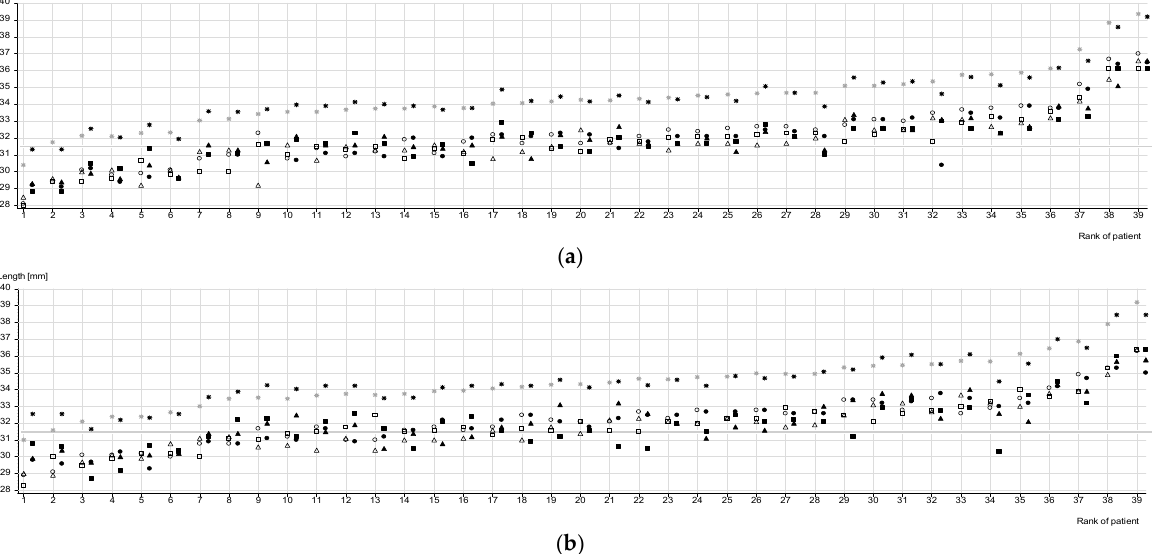
Figure 2. Measurements of the cochlear duct length (CDL) and length at 720° of each cochlea based on CT and MRI of ( a ) left cochleae ( n = 39) and ( b ) right cochleae ( n = 39). Blank white symbols indicate CT-based data, filled black symbols indicate MRI-based data; , = mean CDLs evaluated